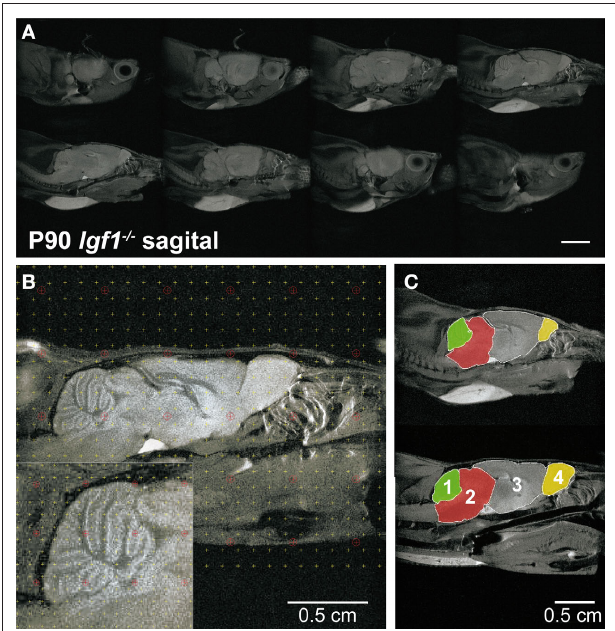
Figure 8 | In vivo brain images of Igf1 + / + wild type and Igf1 − / − null mice. (A) Complete series of brain slices in the sagittal plane of a representative 3-month-old Igf1 − / − null mouse. (B) Sagittal MRI T2 weighted image of a representative 3-month-old wild type mouse showing the stereological grid that was randomly overlaid on each slide to estimate the volume. The inset shows the specific grid used to estimate the volume of specific brain areas, such as the cerebellum. (C) Comparison of the selected brain areas of Igf1 − / − and Igf1 + / + mice: cerebellum (1), brainstem (2), diencephalon-telencephalon (3) and olfactory bulb (4). Note the reduced olfactory bulb in the deficient mice